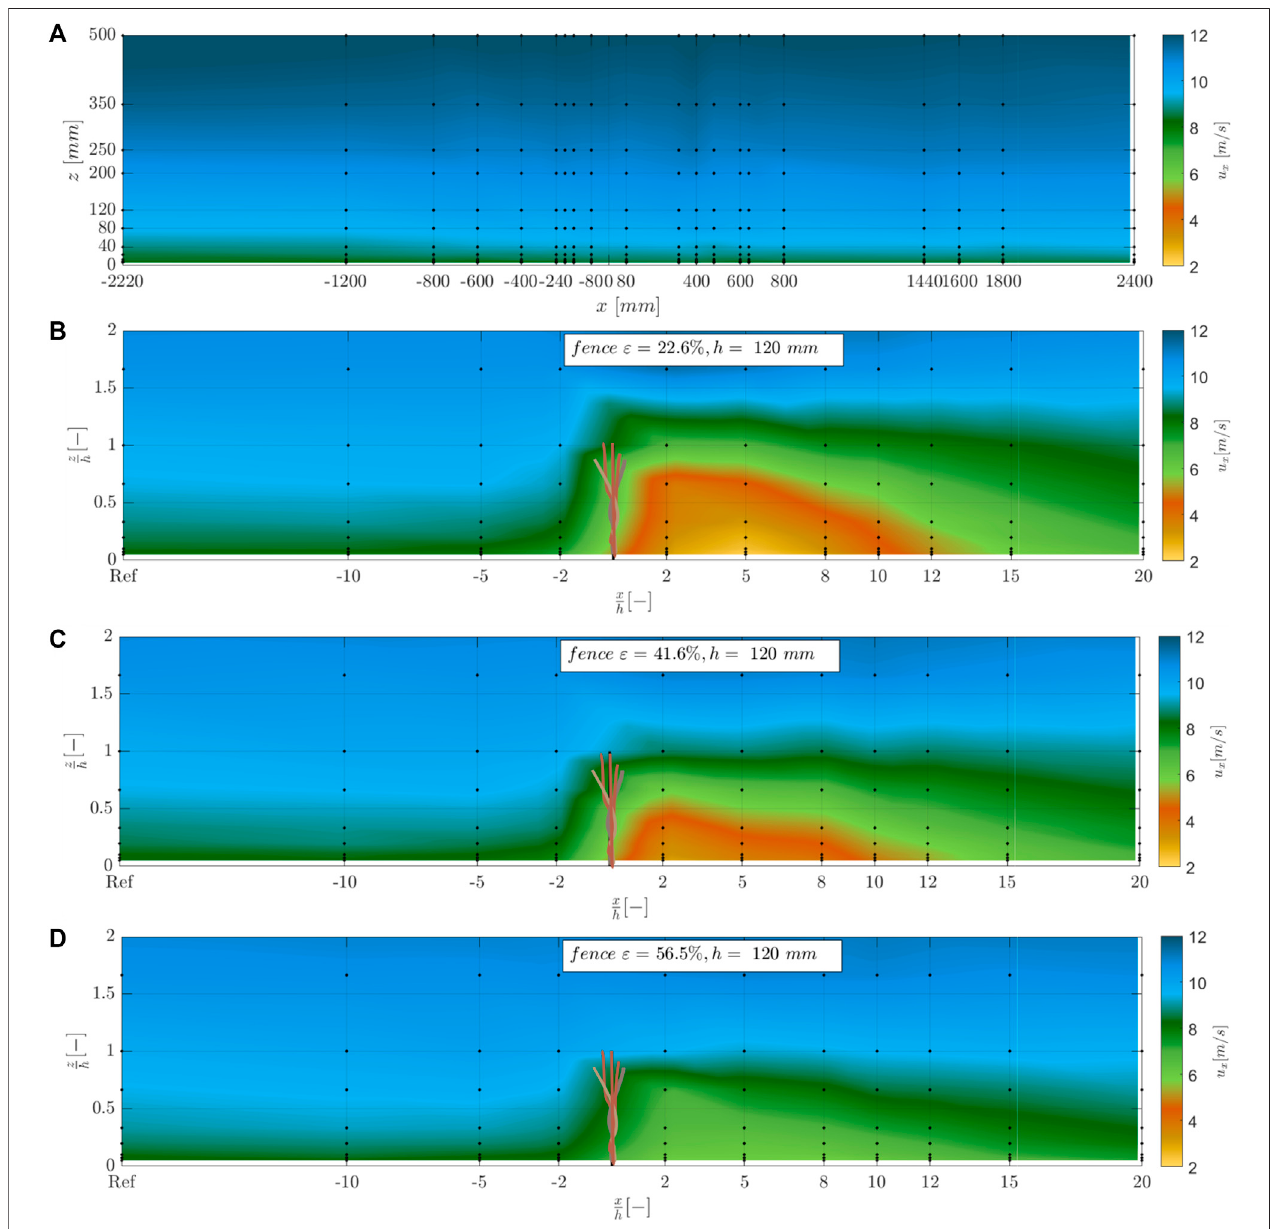
FIGURE7| Flow fi elds (A) withoutasand-trappingfence (B) inthevicinityofasand-trappingfenceat x/h =0with h 3 =120 mmand (B) aporosityof ε 1 =22.6%, (C) ε ε 2 =41.6%,and (D) 3 =56.6%.Thefreemeanwindvelocitywas u 3 =9.3 m/s.Theblackdotsshowthemeasuringlocationsofthehot-wireanemometer,andthebrown lines indicate the sand-trapping